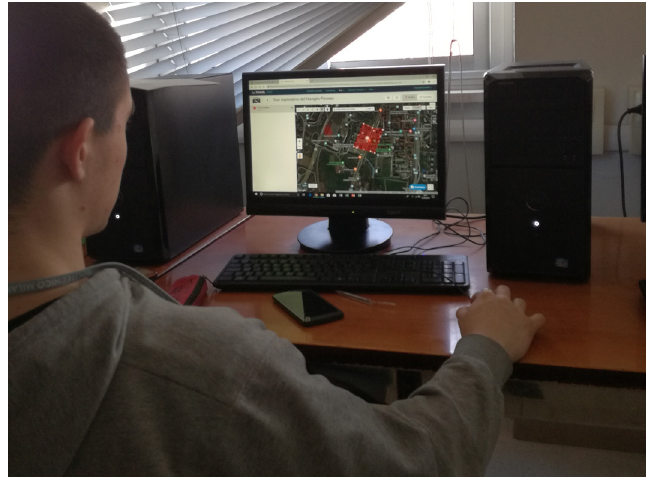
Fig. 9 A Student working on the Izi.travel backend to develop the mobile